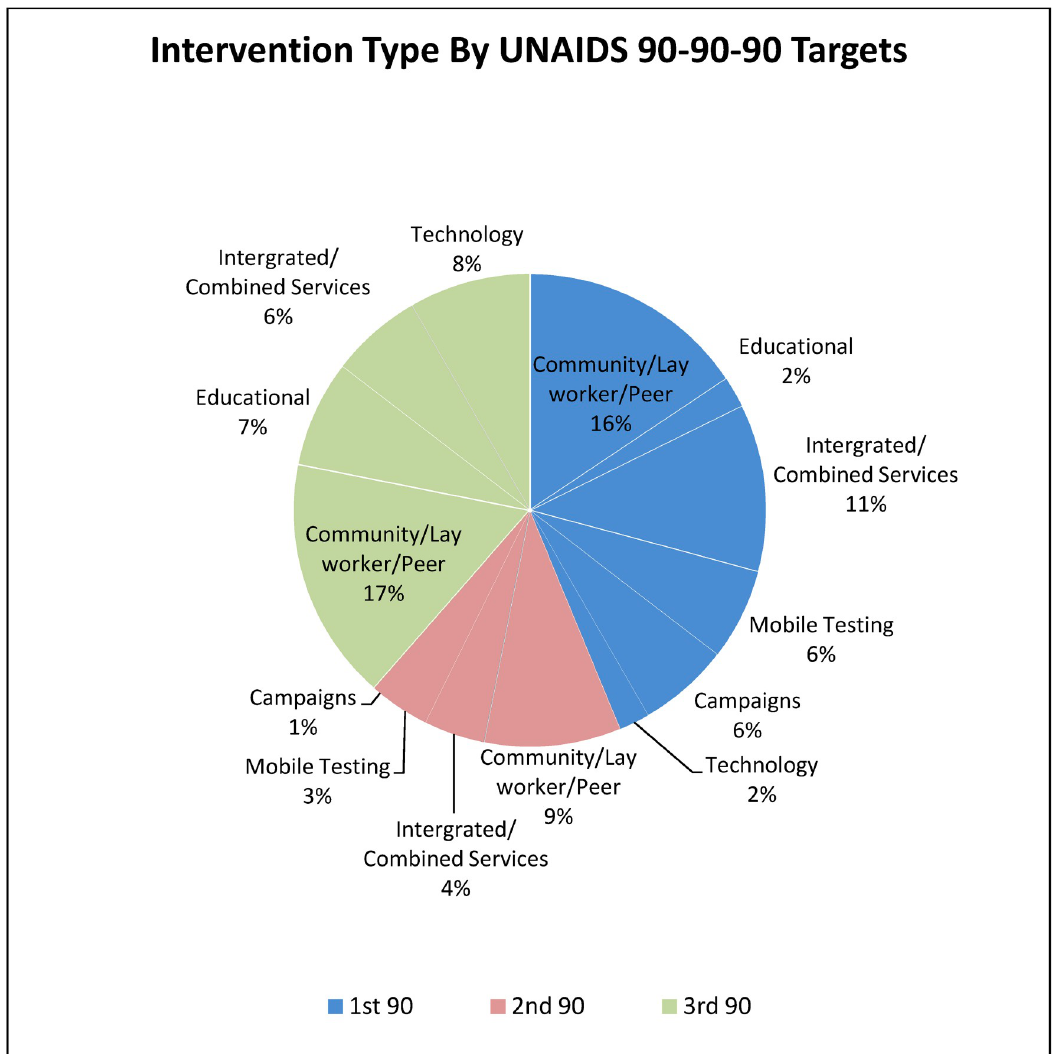
Fig 2. Interventions by UNAIDS 90-90-90 targets and type of intervention. Blue represents interventions related to HIV testing, pink represents interventions associated with linkage to care/treatment and green represents interventions associated with viral